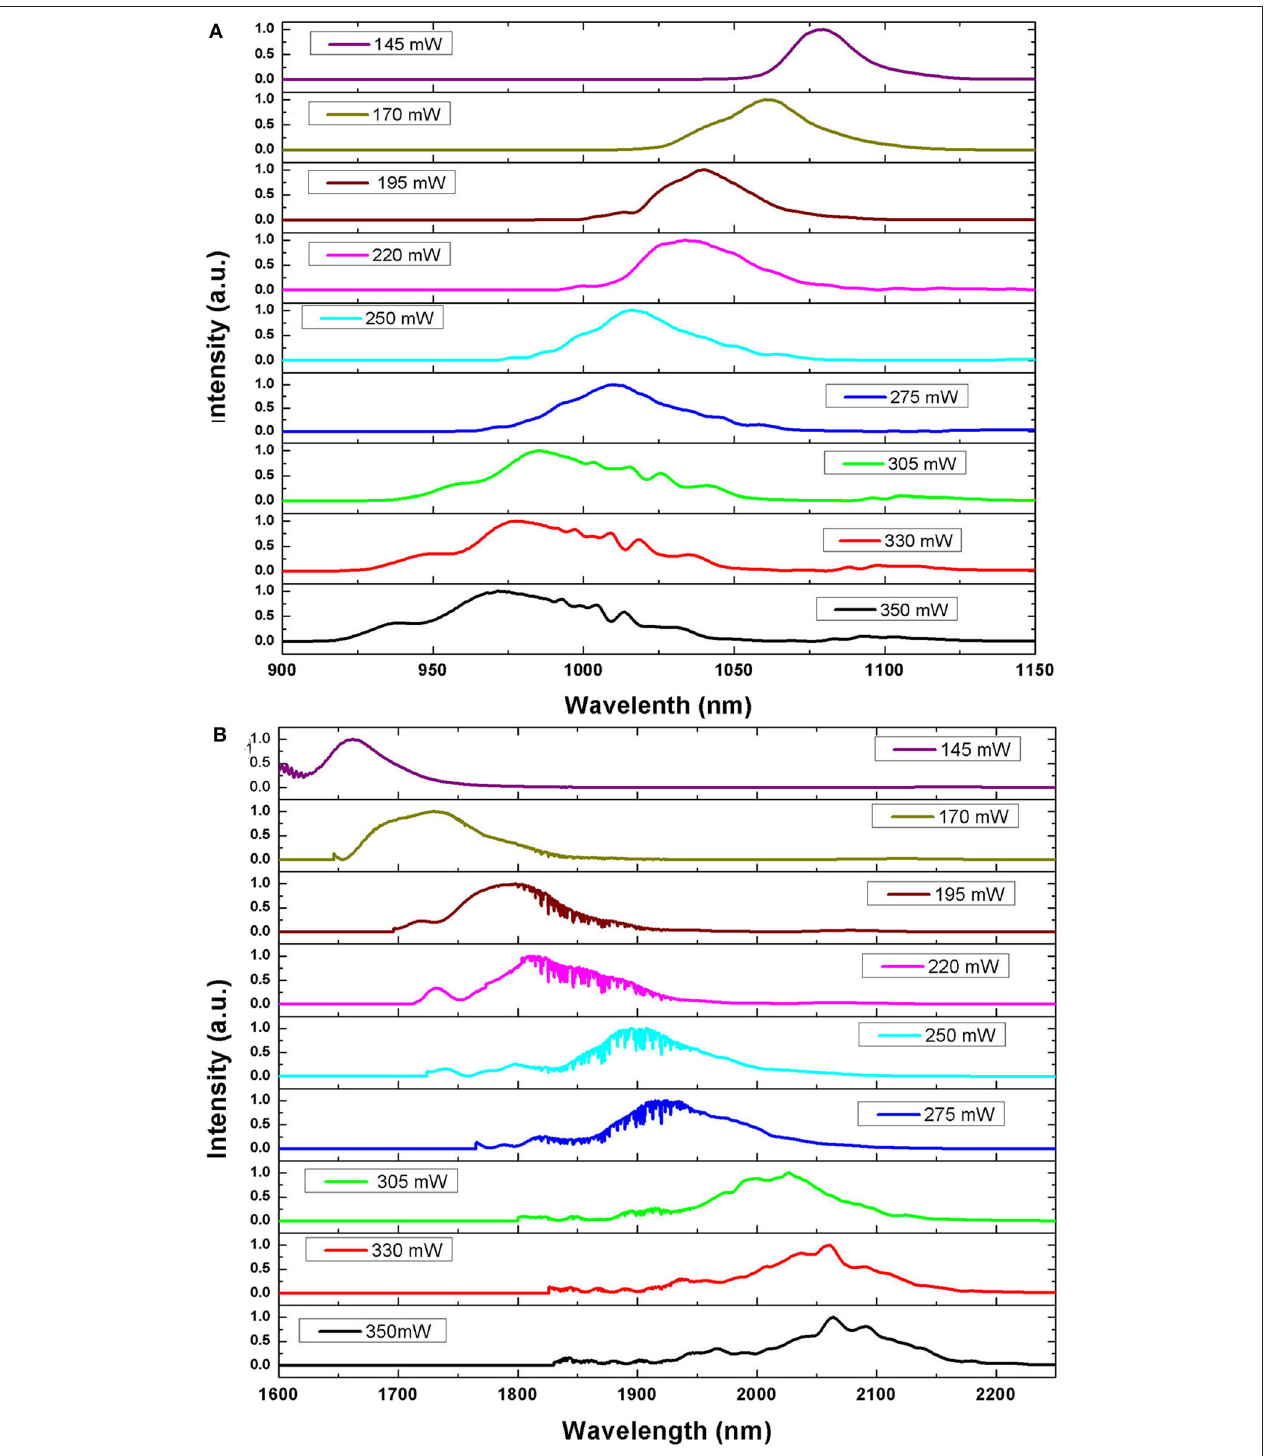
FIGURE 5 | Typical tunable OFC spectrum at different pump power. (A) Short wavelength part; (B) Long wavelength part.